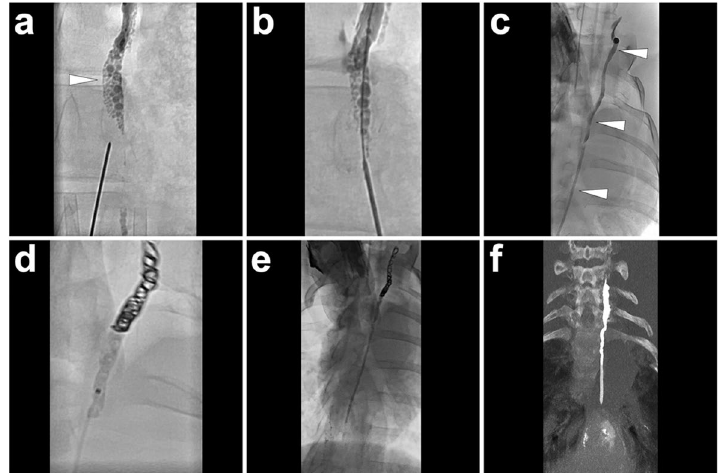
Fig. 8 Illustration of TDE using coils and sequential NBCA/lipiodol mixture embolization. A 22-gauge Chiba needle was punctured into the cisterna chyli ( white arrowhead ) under fluoroscopy ( A ). Then, remove the stylet and coaxially exchange a 0.018-inch guidewire into the thoracic duct ( B ). Coaxially advance a microcatheter into the thoracic duct and conduct an angiography to delineate the complete thoracic duct ( white arrowheads ) using the water-soluble iodinated contrast ( C ). Afterwards, advance the microcatheter into the distal part of the thoracic duct with reference to the angiographic image and release four coils (4 mm*14 cm, Nester ® Embolization Coil, Cook Medical, Bloomington, USA) followed by glue injection (in this pig, 4 ml 1:2 NBCA/lipiodol mixture was used) with the simultaneous withdrawal of the microcatheter under fluoroscopy ( D ). After the accomplishment of embolization, perform the fluoroscopy ( E ) and CT scan (MIP image, F ) to demonstrate the embolized thoracic duct presenting as a linear opacity. Images were from Pig No. 8 . Abbreviations: TDE, thoracic duct embolization; NBCA, N-butyl-2-cyanoacrylate; CT, computed tomography; MIP, maximum intensity